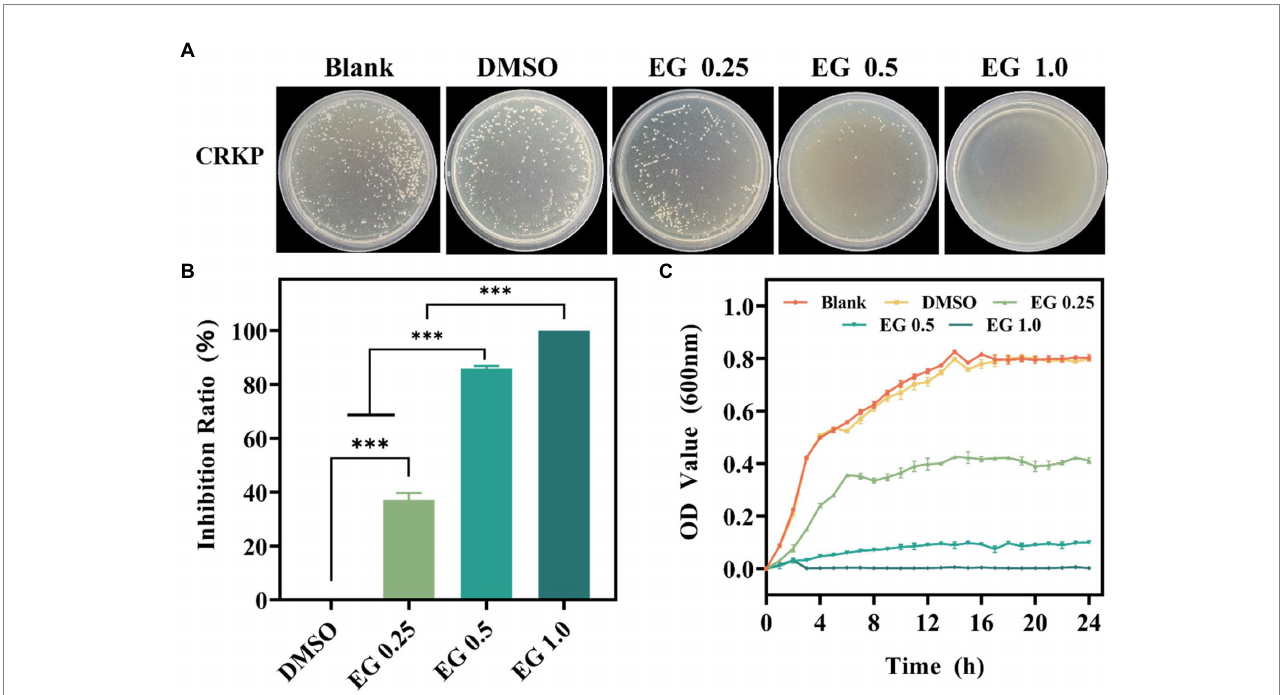
FIGURE 1 (A) The colony photographs of carbapenem-resistant Klebsiella pneumoniae (CRKP) on agar plates after treatment with eugenol (EG) of corresponding concentrations. (B) The calculated inhibition ratio of CRKP at corresponding concentrations of EG. (C) Growth curves of CRKP during co-cultured with EG. ns: p > 0.05, *** p < 0.001. All data are presented as mean ± SD ( n =